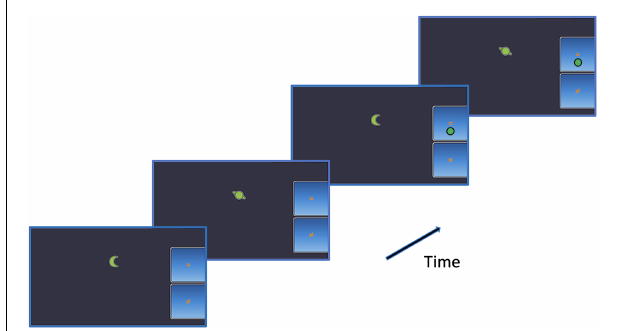
FIGURE 2 | Illustration of the 2-back task. The green circle represents the correct